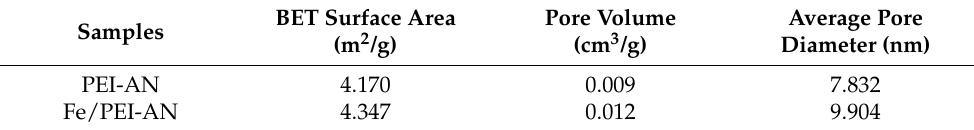
Table 5. BET test results of composite nanofiber